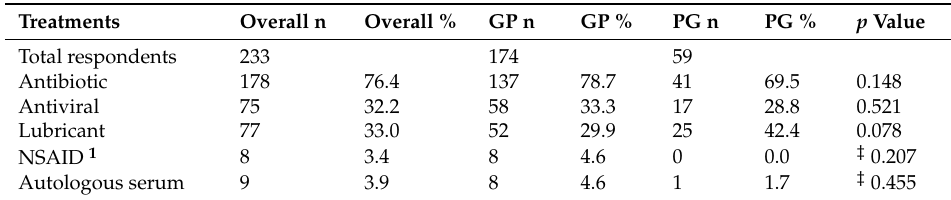
Table 6. FHV-1 keratitis topical treatments recommended by GP and PG groups responding to a Table 6. FHV ‐ 1 keratitis topical treatments recommended by GP and PG groups responding to a vignette questionnaire. vignette questionnaire.